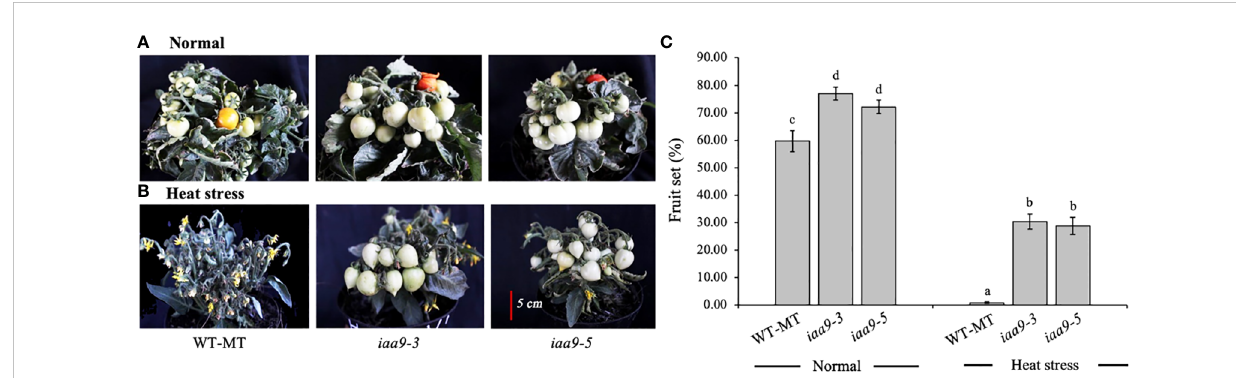
FIGURE 5 Fruit set of WT-MT, iaa9-3 and iaa9-5 under two temperature conditions, i.e., (A) normal temperature and (B) heat stress condition. (C) The average value of fruit set under normal temperature and heat stress conditions. The average value ± standard error (SE) (n = 4) followed by the same lowercase letters is not signi fi cantly different based on Duncan ’ s Multiple Range Test at